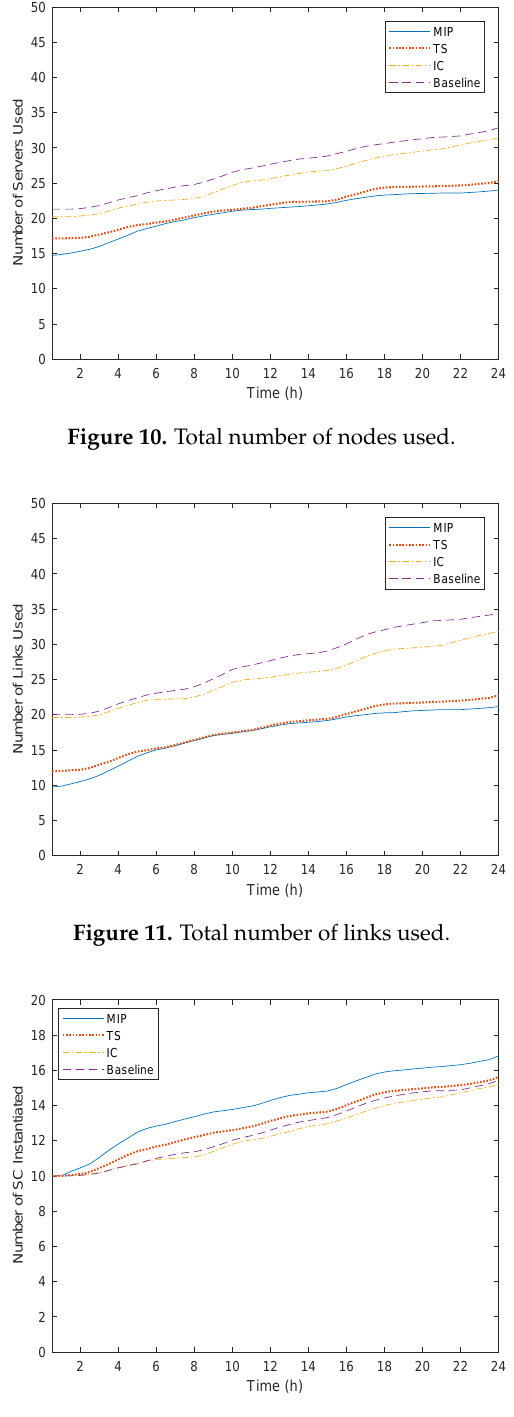
Figure 12. Total number of service chains